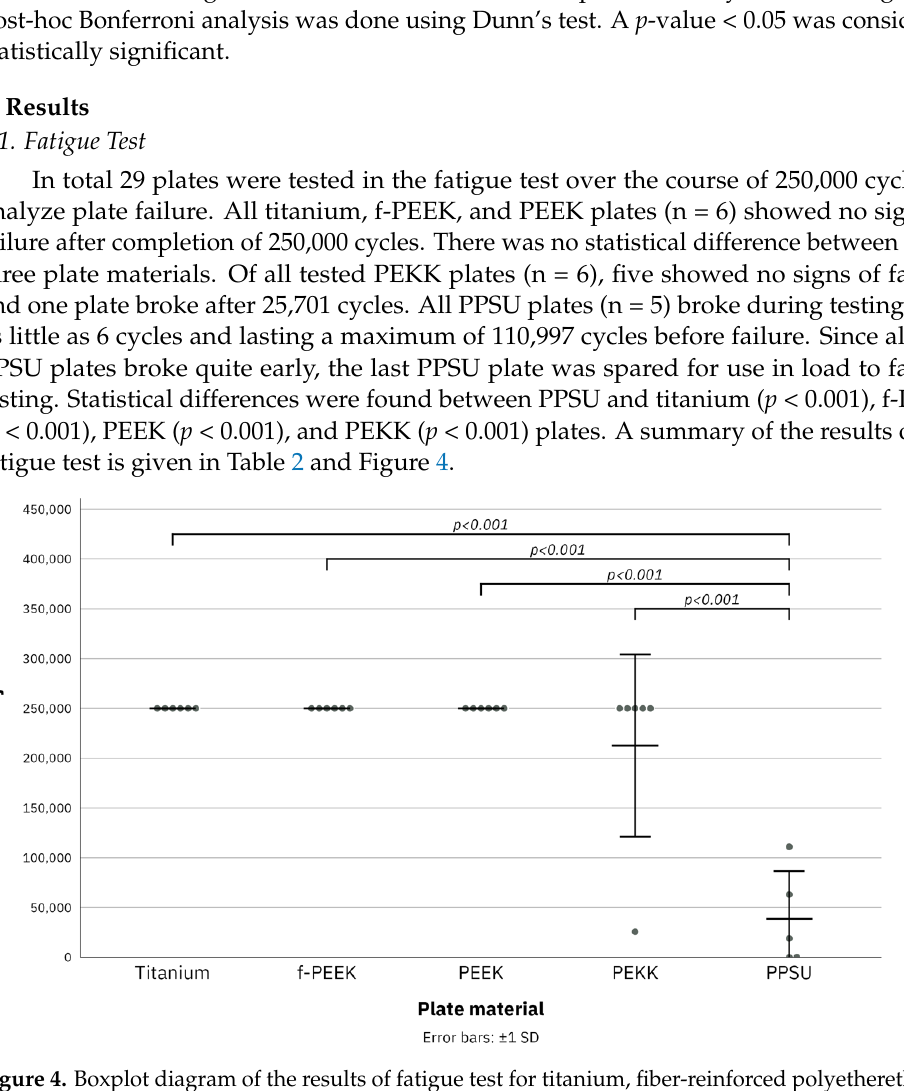
Figure 4. Boxplot diagram of the results of fatigue test for titanium, fiber-reinforced polyetheretherketone (f ‐ PEEK), polyetheretherketone (PEEK), polyetherketoneketone (PEKK) and polyphenylsulfone (PPSU) plates over the course of 250,000 cycles. Error bars: ±1 standard deviation. Jitter display for numbers of the same value.